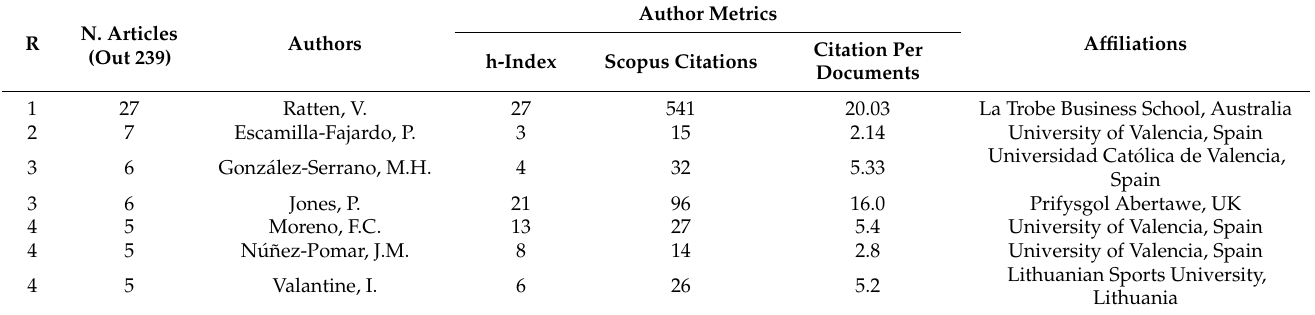
Table 2. Authors with the greatest number of articles